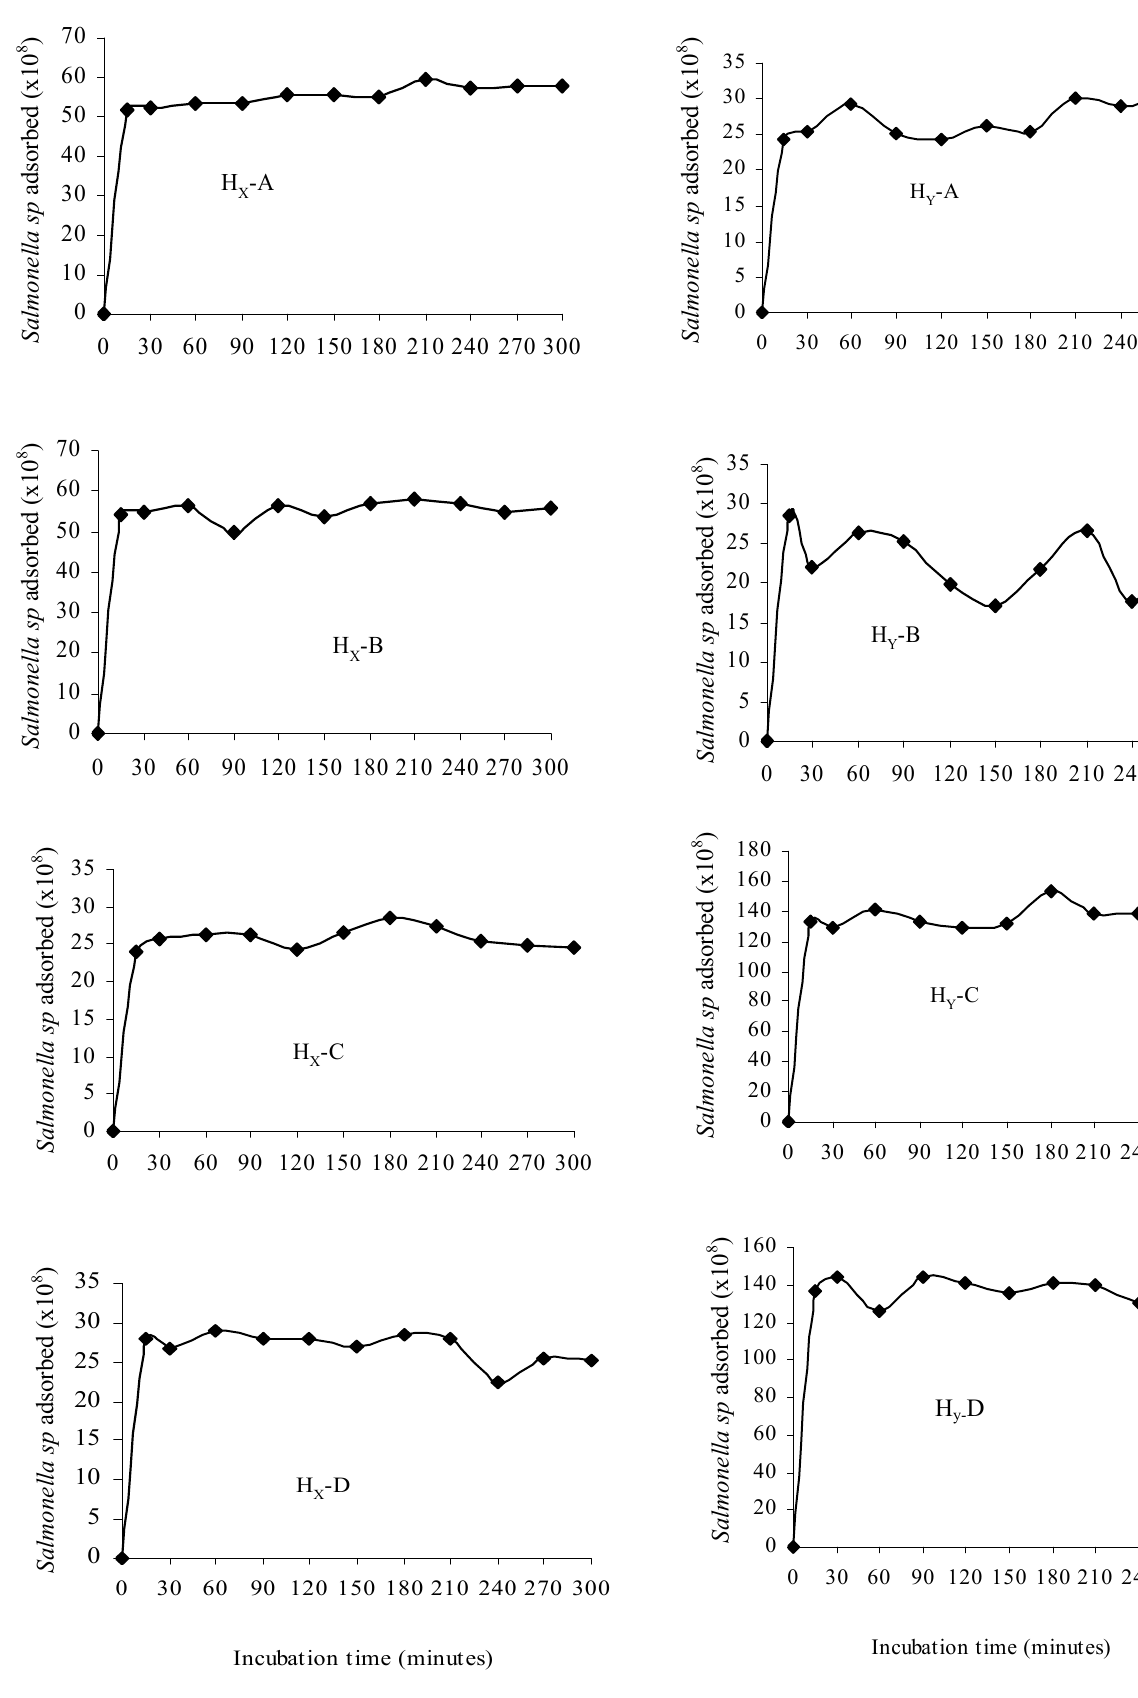
Figure 2: Temporal variations of adsorbed Salmonella sp.mg-1 of soil particles, tests carried out with 500 mg (A), 200 mg (B), 100 mg (C) and 50 mg (D) of soil horizon H